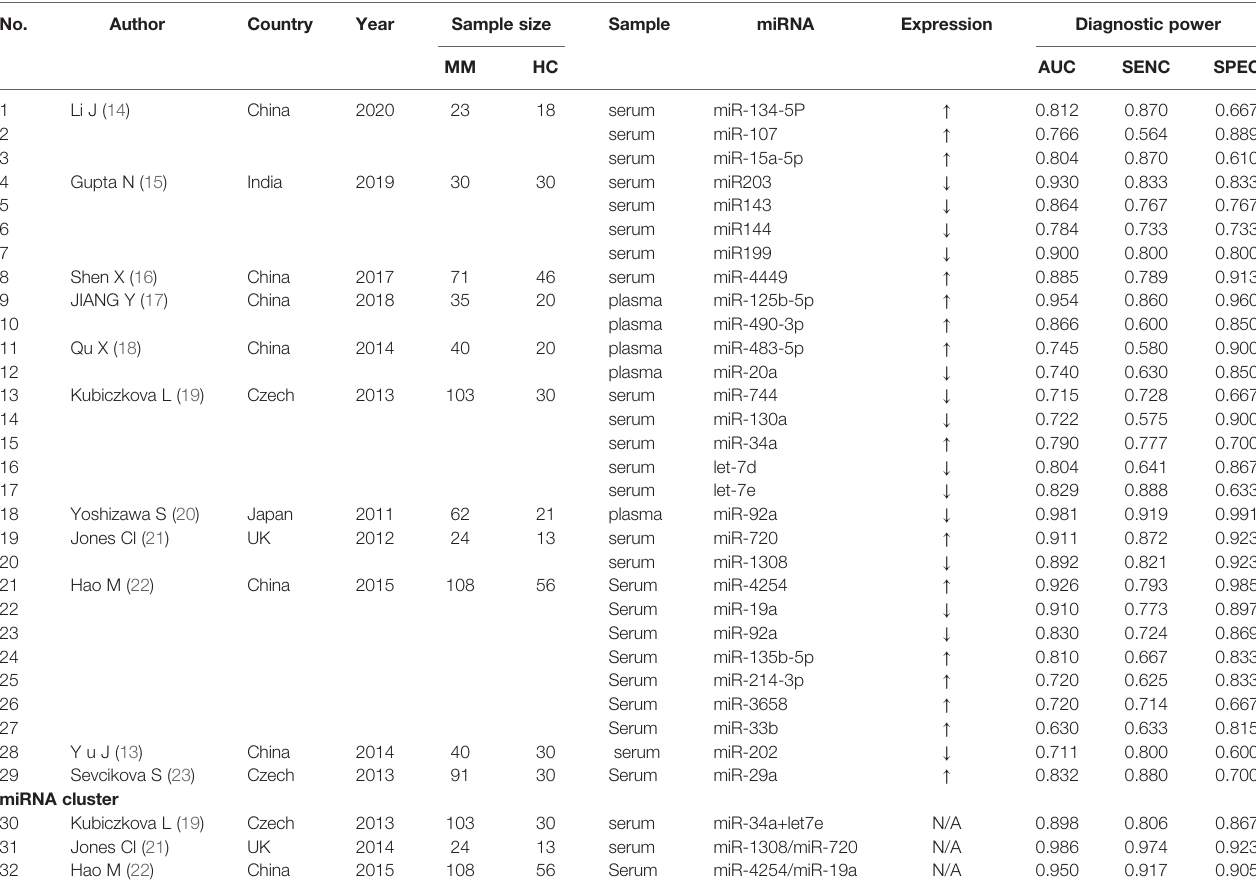
TABLE 1 | Characteristics of studies and the diagnostic power of